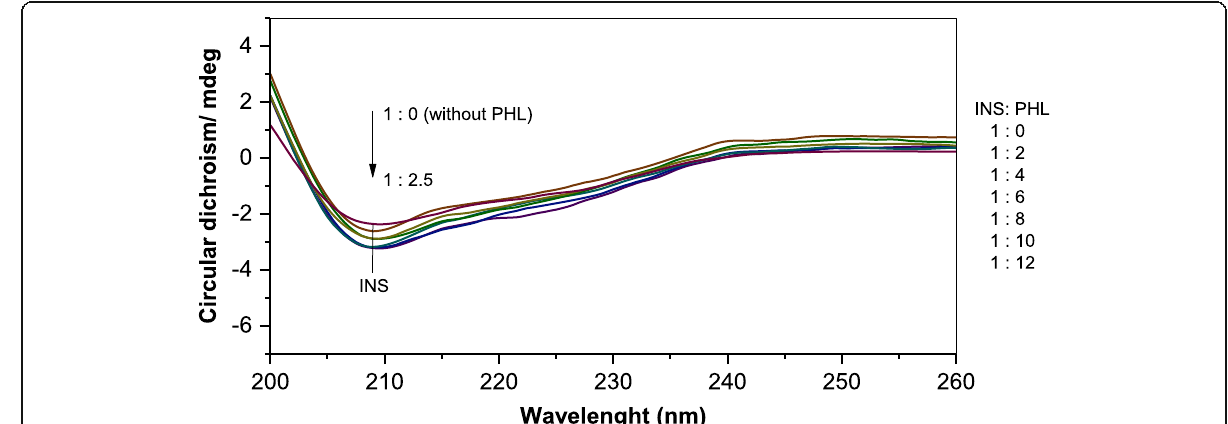
Fig. 10 The circular dichroic spectrum of INS with different concentrations of PHL, T = 298 K